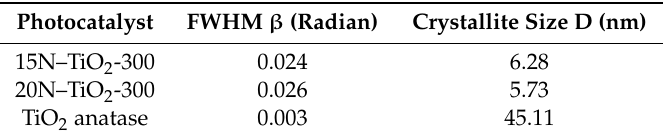
Table 2. Crystallite size of synthesized photocatalysts.